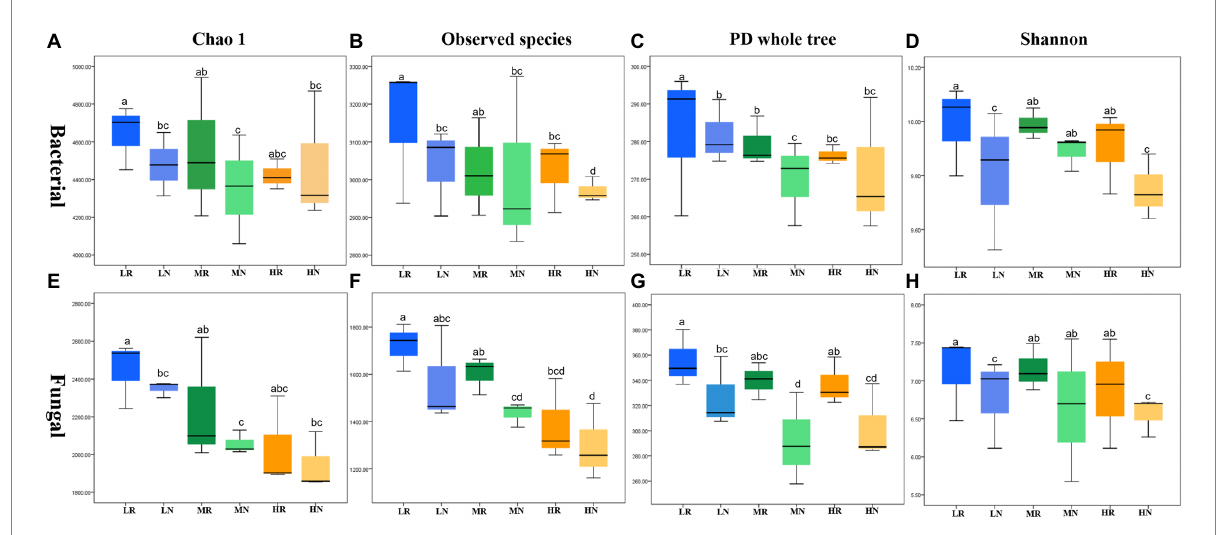
FIGURE 2 The α diversity in different soil samples. Bacteria (A) Chao1, (B) observed species, (C) PD whole tree, (D) Shannon index and fungal (E) Chao1, (F) observed species, (G) PD whole tree, (H) Shannon